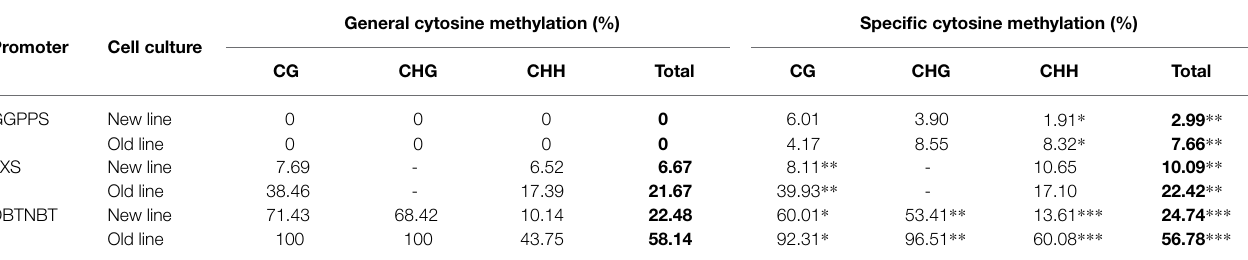
The general cytosine methylation level is represented as the percentage of cytosines reaching 50% methylation. The specific cytosine methylation level is represented as the average of the methylation level of each cytosine context. A p value of < 0.05 ( * ), <0.005 ( ** ), and < 0.001 ( *** ) was used for significant differences. Total percentage of the general and specific cytosine content is indicated in